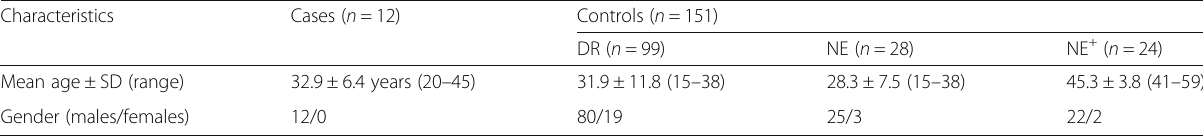
Table 1 Characteristics of SUNDS cases and